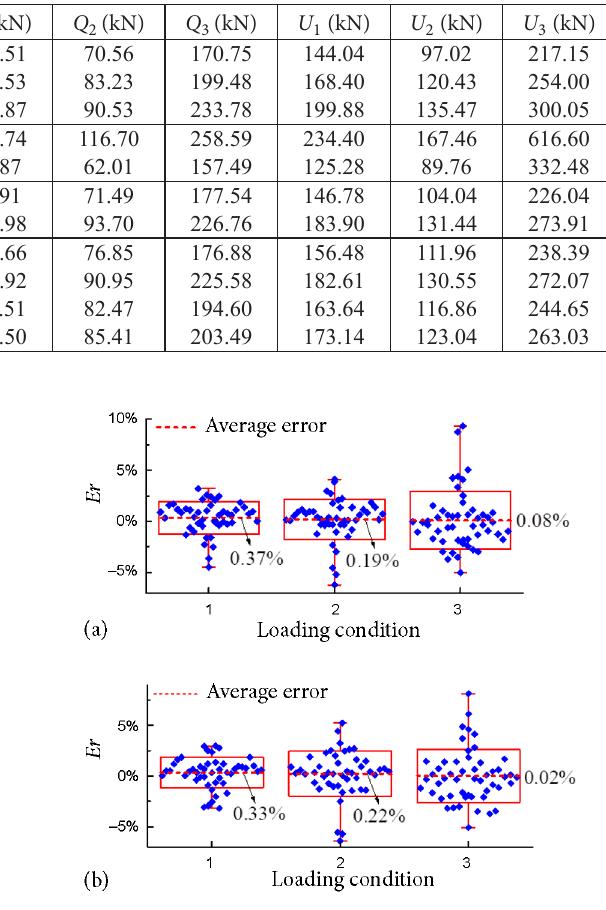
Figure 14. The range of the errors under three different loading cases for calculating failure and ultimate loads of the CFST arches: a – the calculating errors of failure loads; b – the calculating errors of ultimate